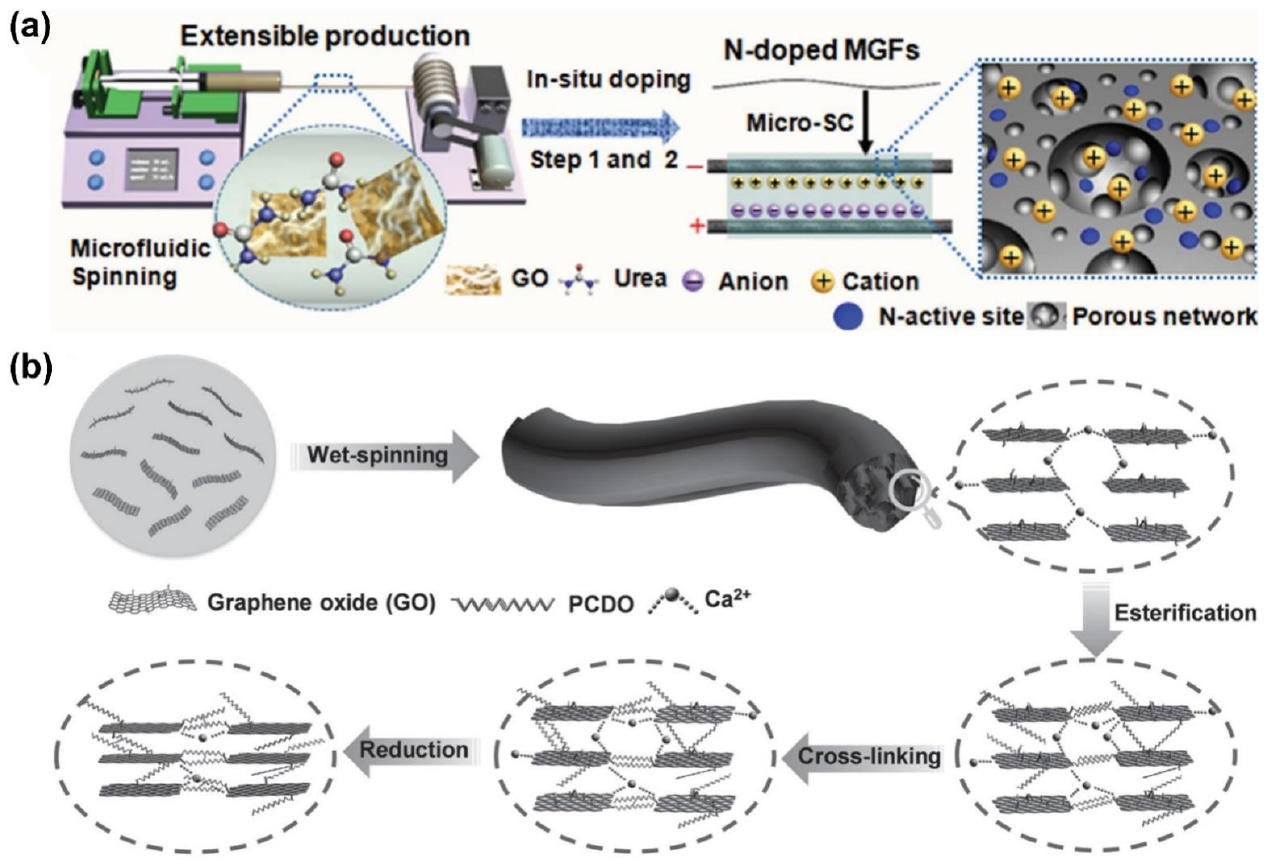
Figure 7. ( a ) Schematic illustration of the preparation of N-doped microfluidic-directed graphene fibers [116] (copyright permission Wiley-VCH 2017); ( b ) Schematic illustration of the preparation process for the bioinspired rGO-Ca 2+ -PCDO fibers [118] (copyright permission Wiley-VCH 2016).